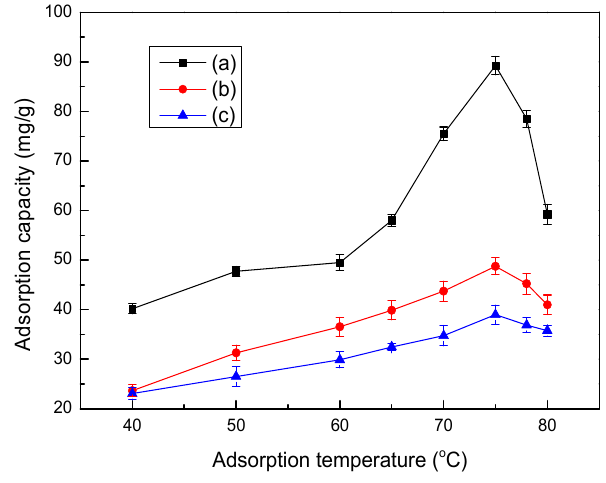
Figure 7. Effect of temperature on adsorption capacity of LMT ( a ), MT ( b ), and LC ( c ). Adsorbent: 0.1000 g; initial Co(II) concentration: 0.0040 mol/L; pH: 5.6; and time: 60 min.